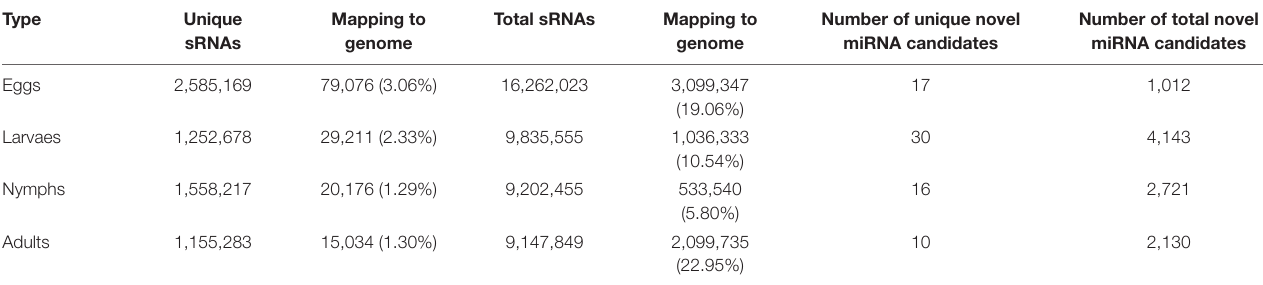
TABLE 3 | Mapping the clean tags back to genome by SOAP2 to analyze the expression and distribution of sRNA tags across the genome.